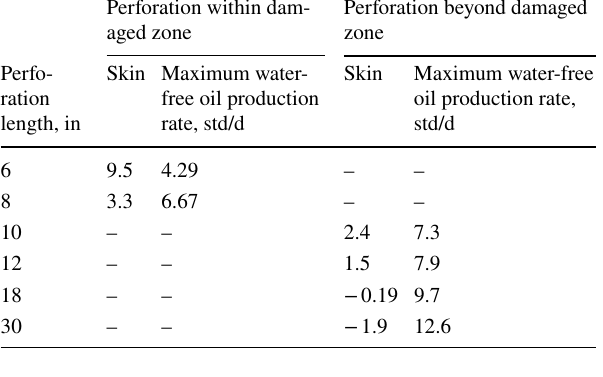
Perforation beyond damaged zone